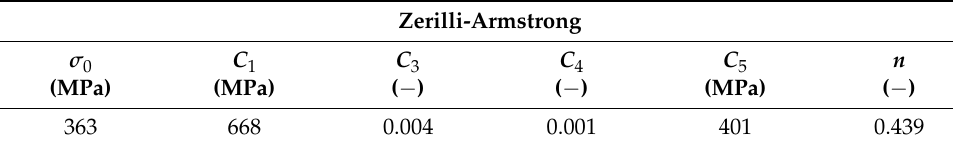
Table 4. Material constants, ZA model.